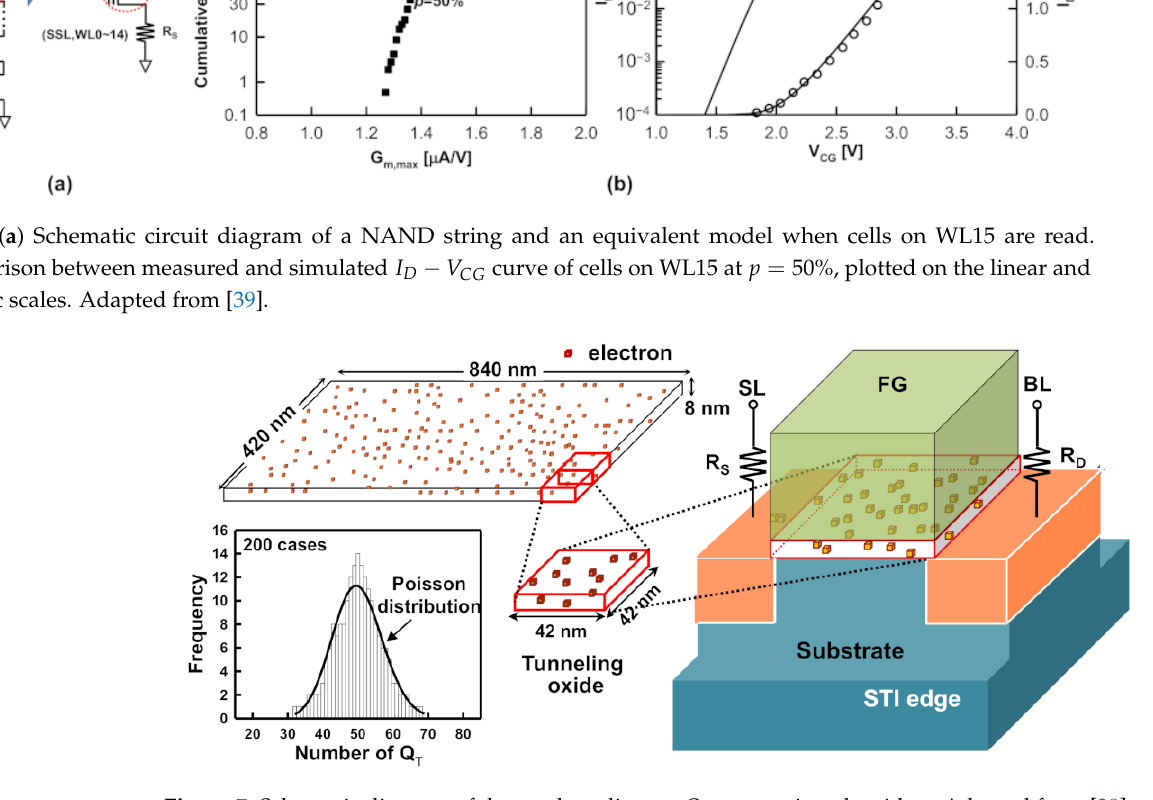
Figure 7. Schematic diagram of the random discrete Q T generating algorithm. Adapted from